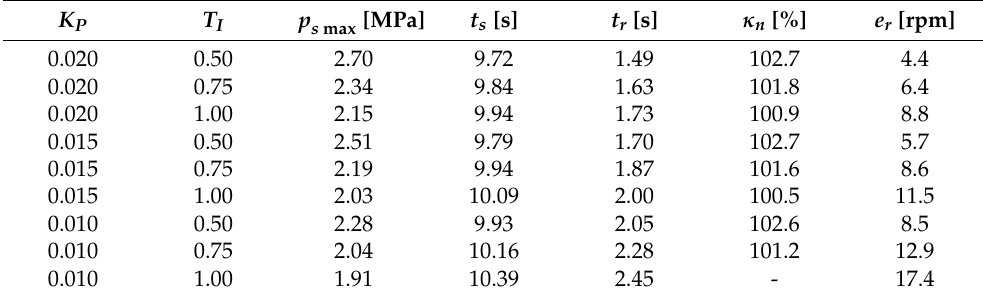
Table 2. Comparison of the parameters of the PI controller and the obtained values of the dynamic surplus pressure on the motor, the start-up time, the reaction time, and the